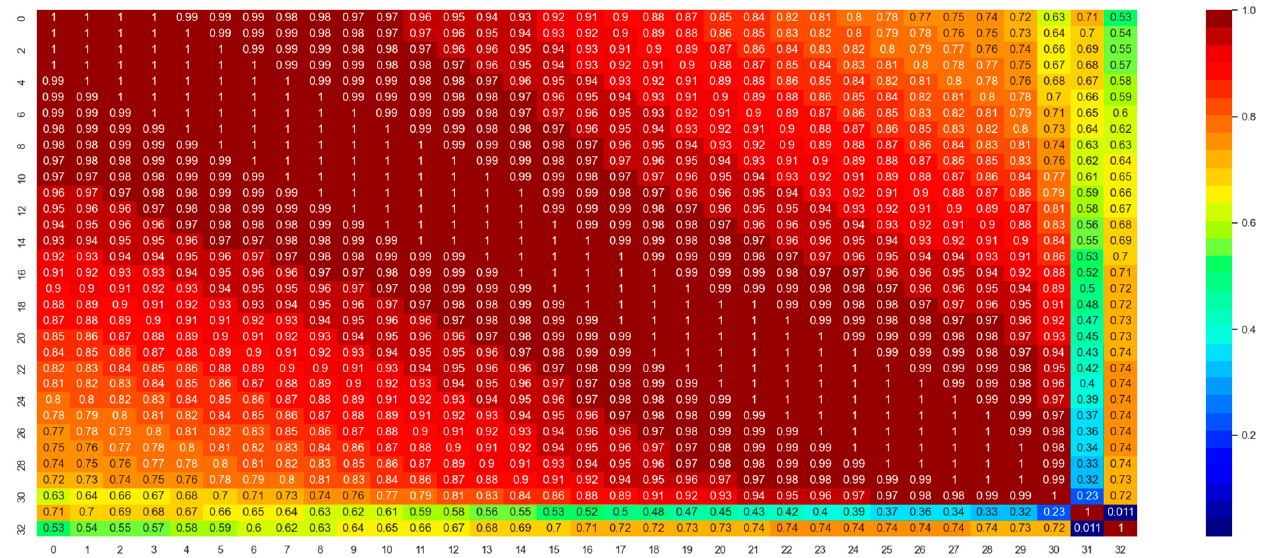
Figure 8. Correlation matrix for dataset A. Here, columns indexed by from 0 to 31 are the features, and the column with index 32 contains the labels.